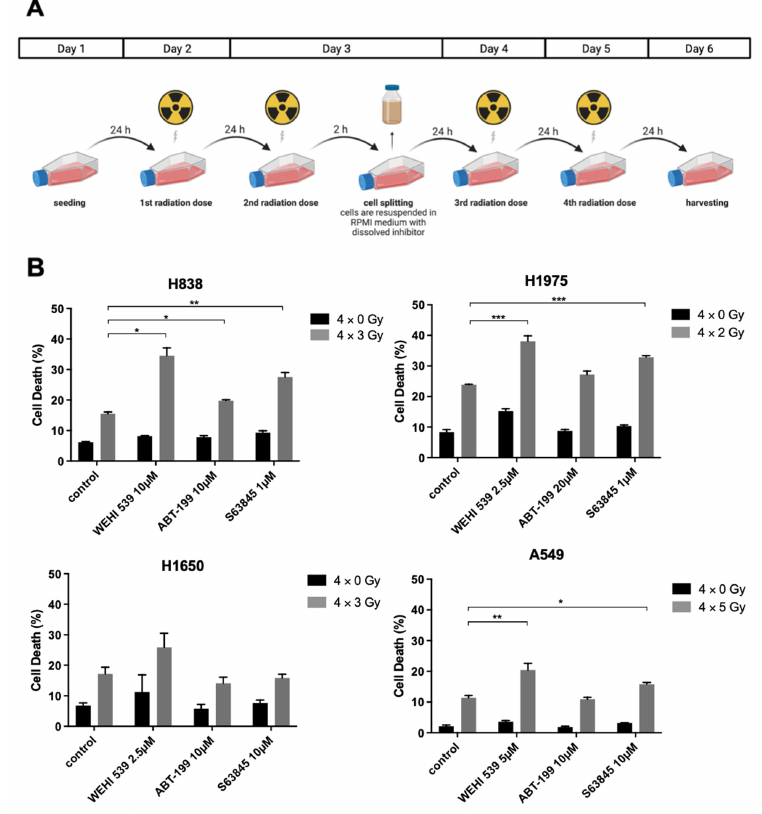
Figure 3. Set up for in vitro experiments and radiosensitization results of NSCLC cell lines ( A ) Cell lines undergoing a fractioned radiation schedule during molecular inhibition with BH3 mimetics. ( B ) Combination of irradiation and molecular inhibition in NSCLC cell lines and FACS analysis of induced cell death. Experiments were performed in triplicate and cell death was measured as mean ± SD. The depicted FACS analyses are representative of at least three independent experiments. * p ≤ 0.05, ** p ≤ 0.01, *** p ≤ 0.001.